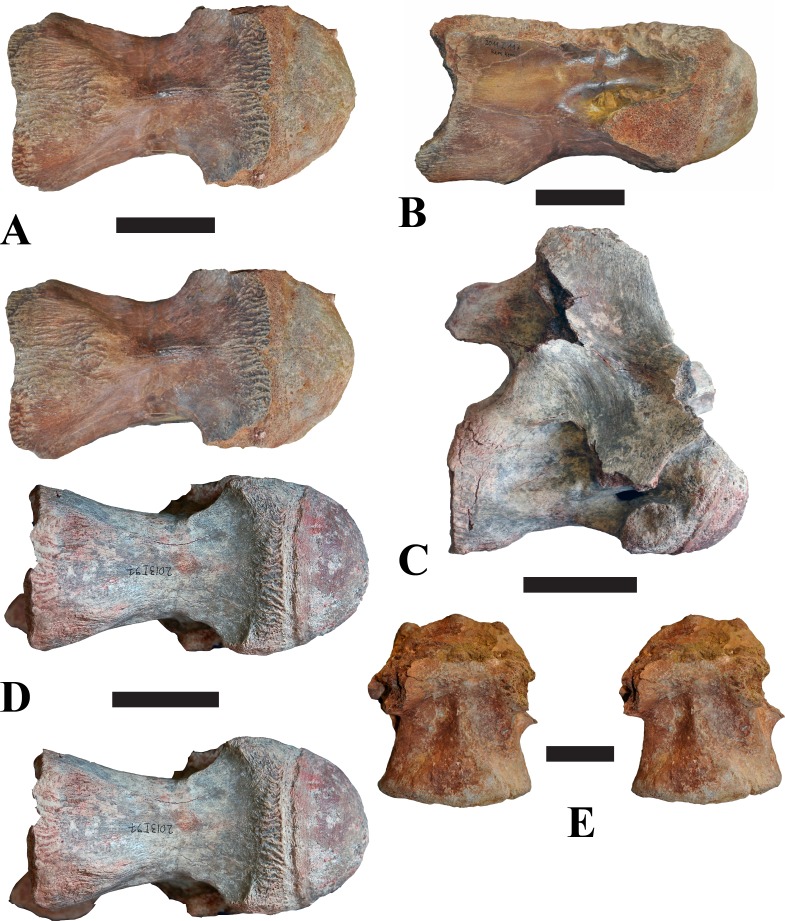
Stereographic comparisons of spinosaur cervical vertebrae from the Kem Kem compound assemblage.(A) stereopair showing ventral view of BSPG 2011 I 117, Sigilmassasaurus brevicollis; (B) right lateral view of BSPG 2011 I 117; (C) right lateral view of BSPG 2013 I 97; (D) stereopair showing ventral view of BSPG 2013 I 97, Spinosauridae indet.; (E) stereopair showing ventral view of BSPG 2006 I 56, Sigilmassasaurus brevicollis. Note triangular plateau in Sigilmassasaurus and prominent step in lateral outline in mid-cervicals, and ventral lateral tubercula with central depression and weak lateral step in BSPG 2013 I 97. Scale bars equal 5 cm.